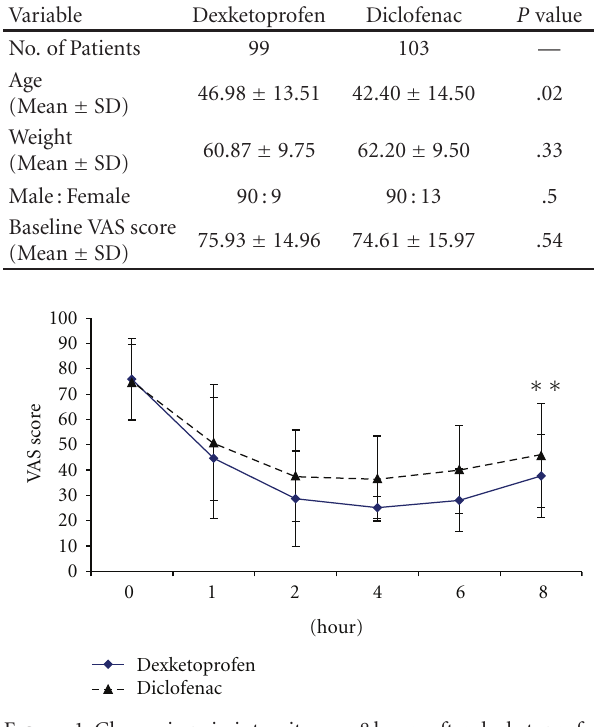
Figure 1: Change in pain intensity over 8hours after dexketoprofen and diclofenac injection. ∗∗ P value between the group at 8 hours = .003 calculated using unpaired t test.